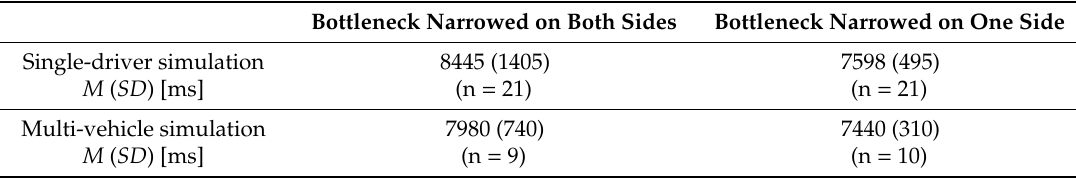
Figure 14. Participants average passing time in the case that the AV yields the right of way to the oncoming human driver divided by the bottleneck type. The data of the single-driver simulation are derived from Rettenmaier et al. [30]. Table 3. Descriptive data of the participants’ passing time. The data of the single-driver simulation are derived from Rettenmaier et al. [30].